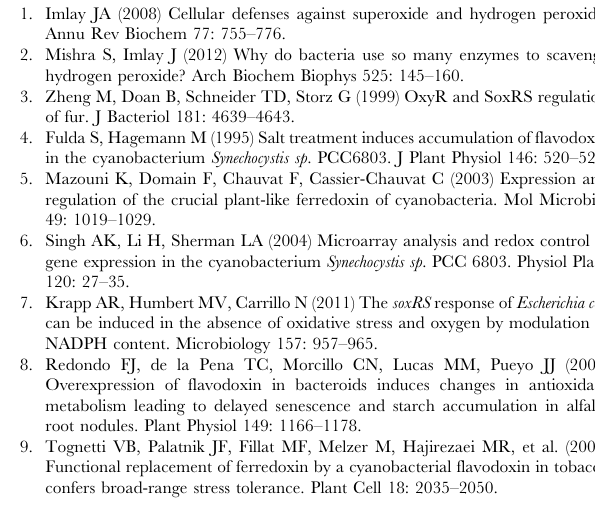
protein; lanes 3–4, 20 m l of flow-through the column; lanes 5– 11, 20 m l of successive eluates with 500 mM imidazol. MW markers are shown. Figure S2 Growth curves of P. aeruginosa strains. P. aeruginosa cells from wt, fldP and fldP p2- fldP strains were grown in LB medium, and appropriate dilutions were plated at 2, 4, 8 and 24 h post inoculation for colony counting. Experiments were performed in duplicate and the results are expressed as means 6 SD. (TIF) Figure S3 Presence of the fldP gene in clinical and environ- mental P. aeruginosa isolates. The presence of the fldP gene was evaluated by PCR analysis in a collection of clinical P. aeruginosa isolates which had been obtained from 25 different patients and determined as being clonally different by pulse-filed gel electro- phoretic analysis as described previously [36], and in the environmental strain Hex1T [35]. P. aeruginosa strains PA14 and PAO1 were used as positive and negative controls, respectively. Amplification of the rpoD gene was employed as template loading control for agarose gel electrophoresis. Capital letters under each lane correspond to different clinical isolate genotypes. Table S1 Genic composition of RGP32 in P. aeruginosa strain